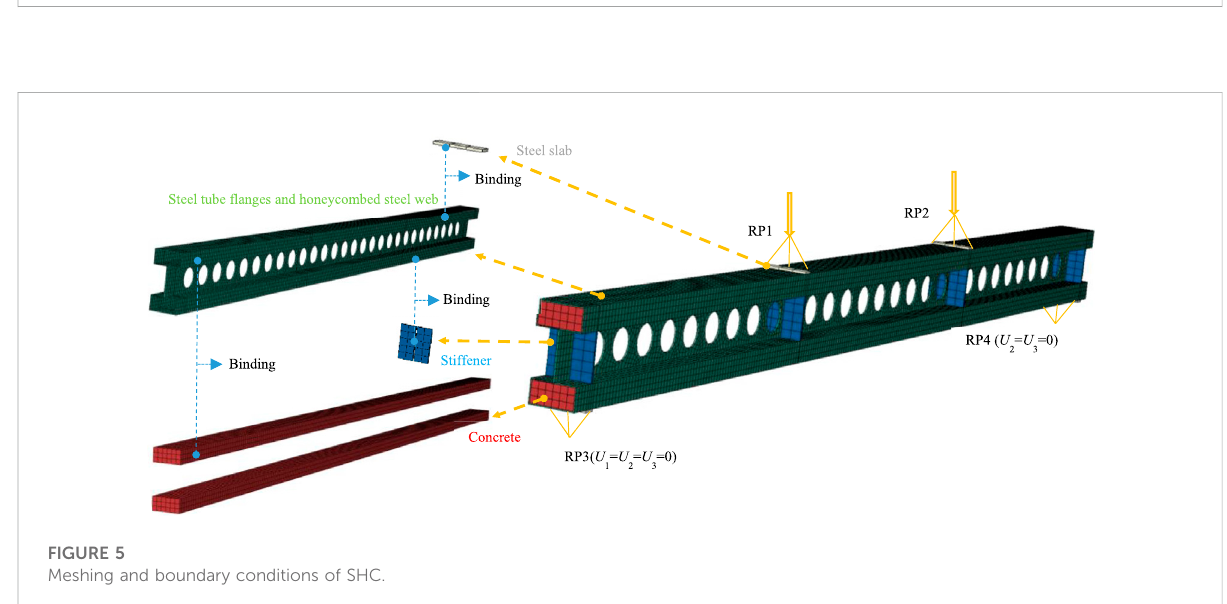
FIGURE 5 Meshing and boundary conditions of